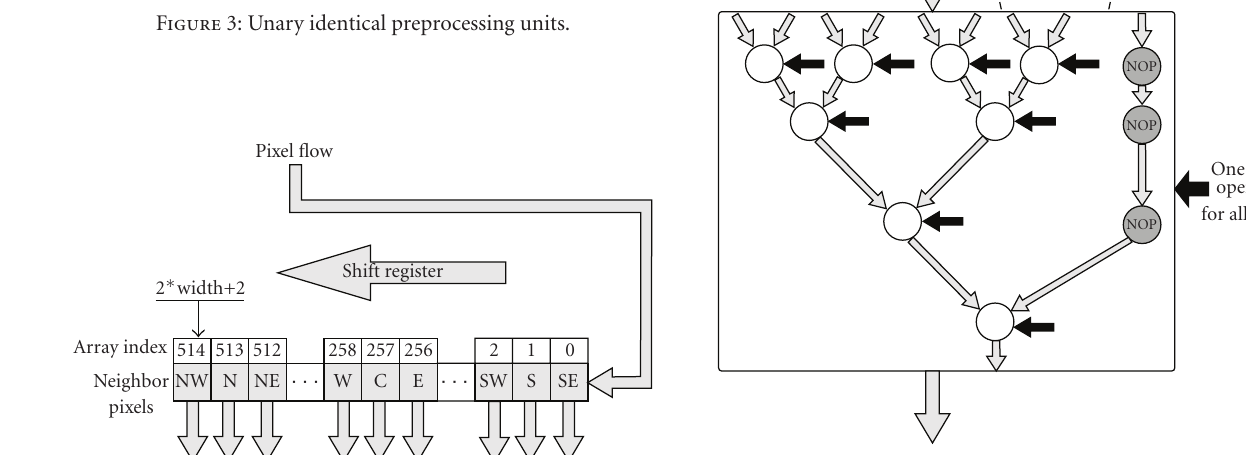
Figure 6: Reduction processing